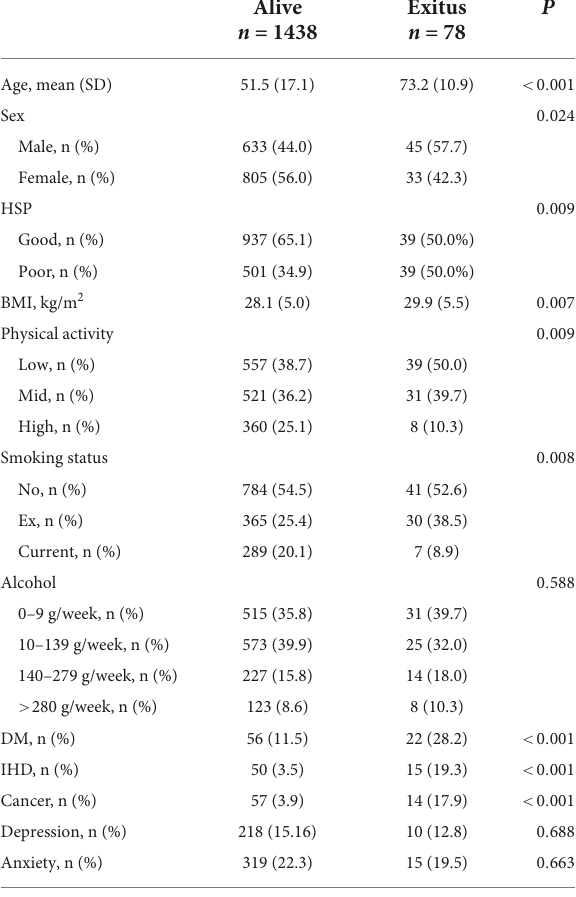
TABLE 3 Demographics, lifestyle, and comorbidities for patients at 5–8 years of follow-up.